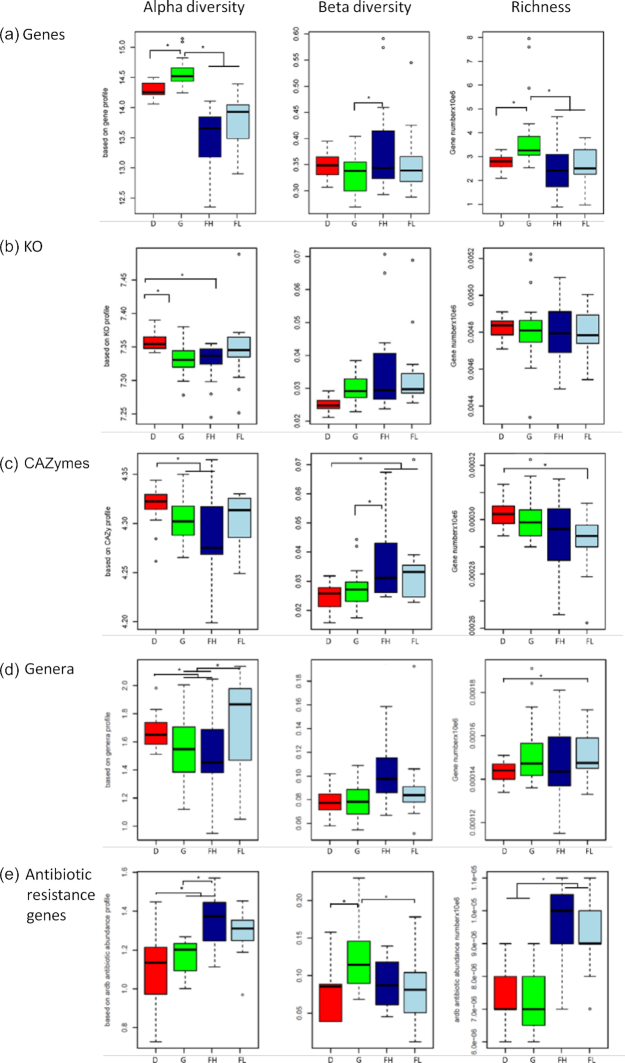
Effect of diet on diversity indexes of the bovine rumen microbiome. Comparison of α-diversity, β-diversity, and richness at gene (a), KEGG orthologs (KO) (b), carbohydrate-active enzymes (CAZymes) (c), genera (d), and antibiotic resistance gene (e) levels among cattle fed dairy (D, red, n = 23), fattening high-starch (FH, dark blue, n = 16), fattening low-starch (FL, light blue, n = 18), and grazing (G, green, n = 20) diets. Asterisk indicates P < 0.05. line inside box is median, lower and upper box edges indicate interquantile range (IQR) (25th to 75th percentile, maximum dotted line = Q3 + 1.5*IQR, minimum dottet line = Q1 –1.5*IQR, dots outside line range are outliers.